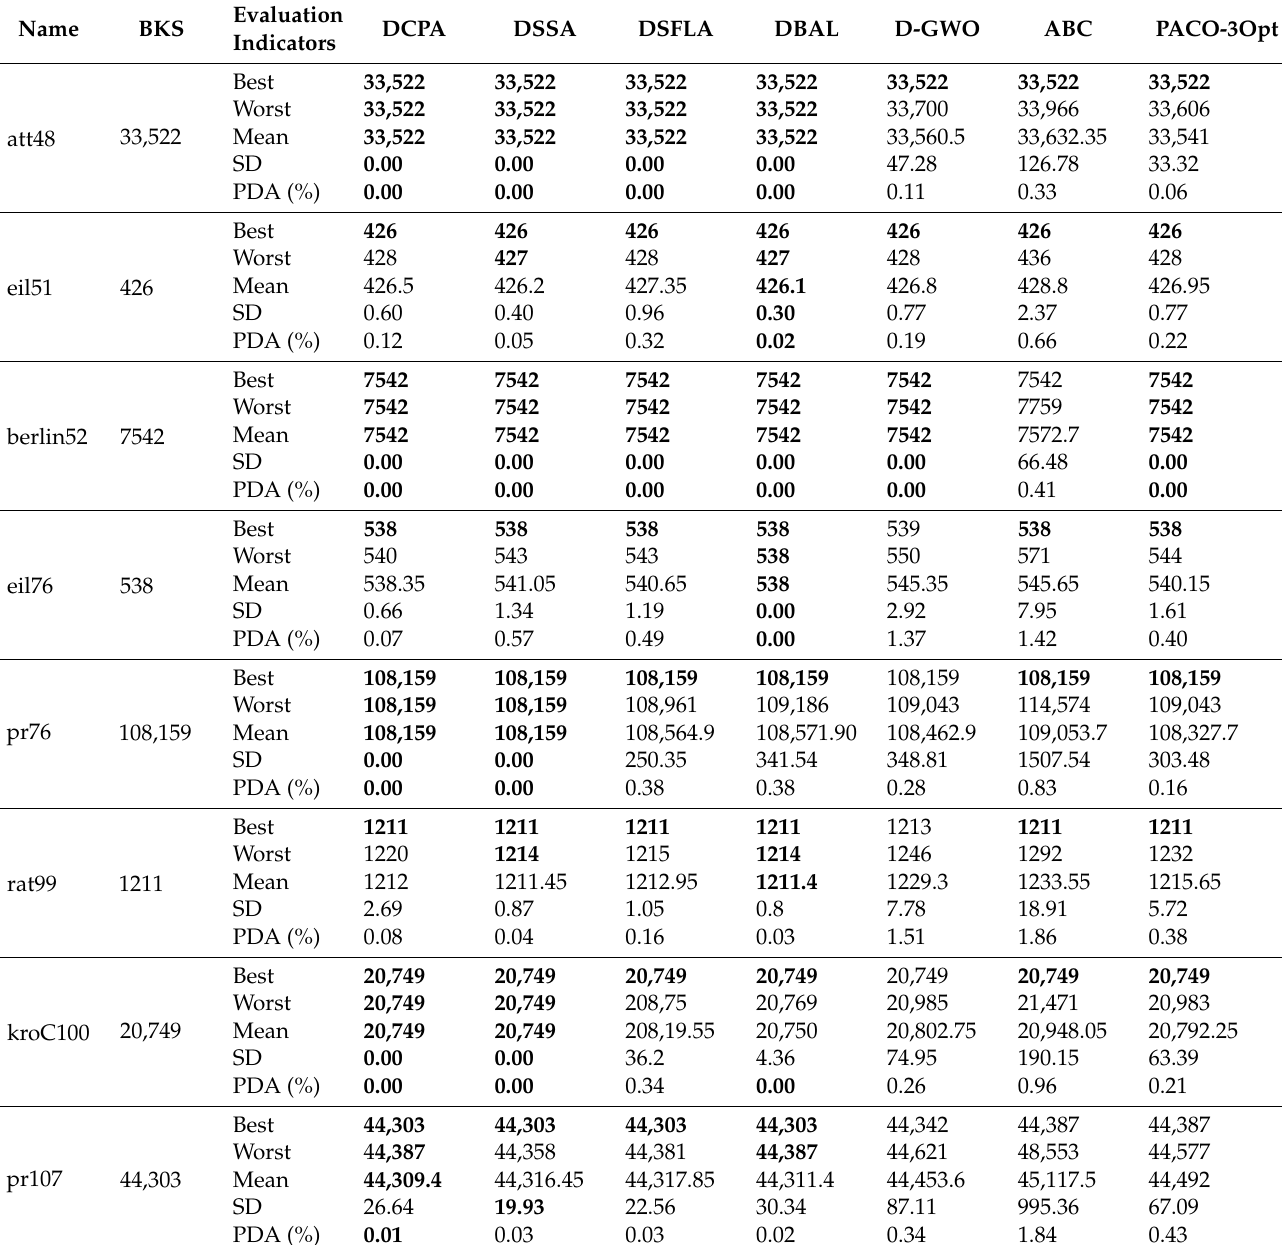
Table 15. Experiment results of the DCPA and the six other participating